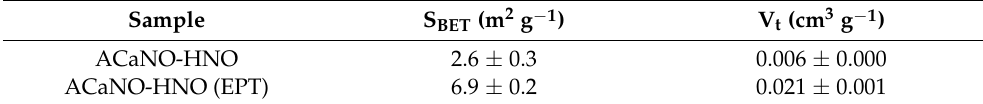
Table 2. BEC samples’ textural parameters obtained by N 2